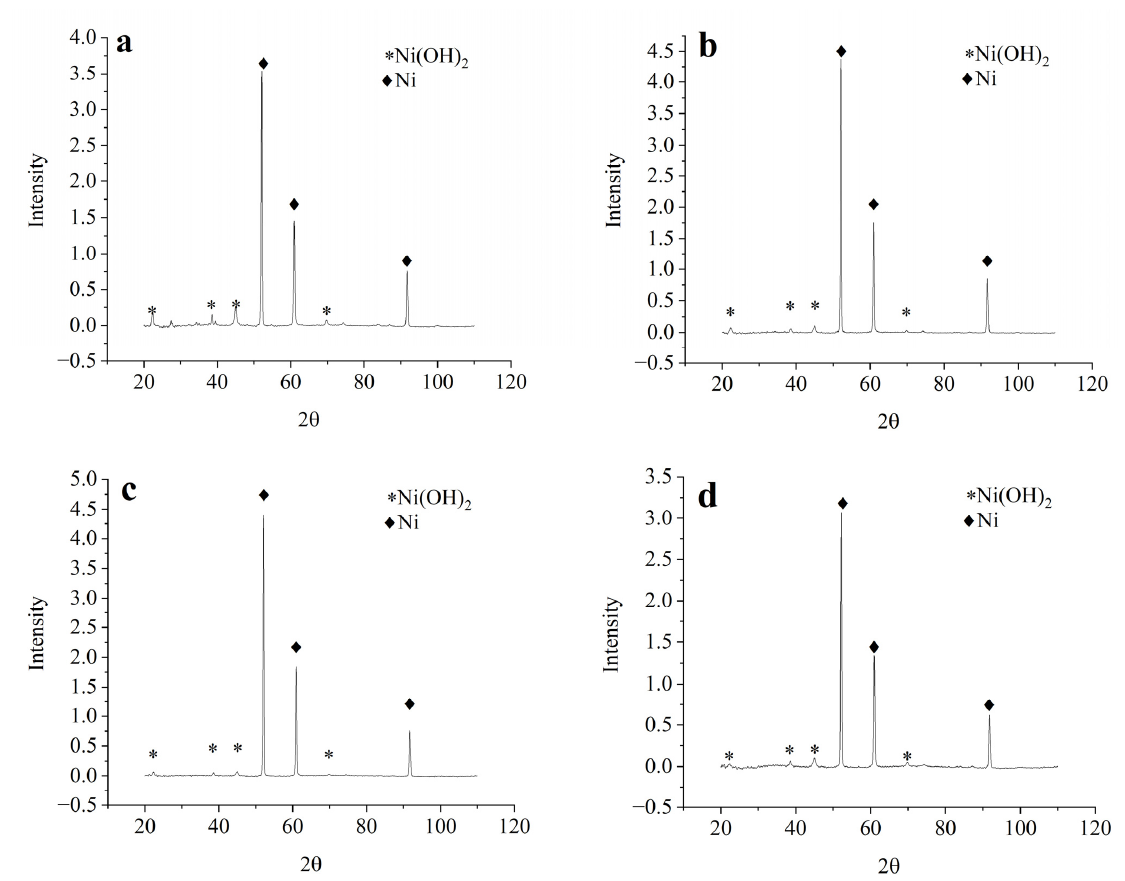
Figure 2. X-Ray diffractograms recorded for formed electrodes: ( a ) Ni(OH) 2 -pure; ( b ) Ni(OH) 2 -PVP; ( c ) Ni(OH) 2 -PVP-Co-elchem; ( d ) Ni(OH) 2 -PVP-Co-chem. ( c ) Ni(OH) 2 -PVP-Co-elchem; ( d ) Ni(OH) 2